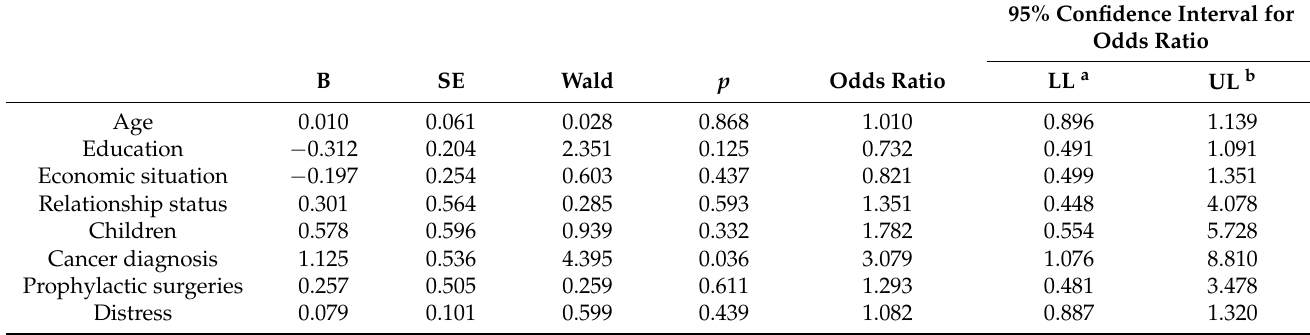
Table 2. Results of the binary logistic regression for the desire for children ( n = 91).